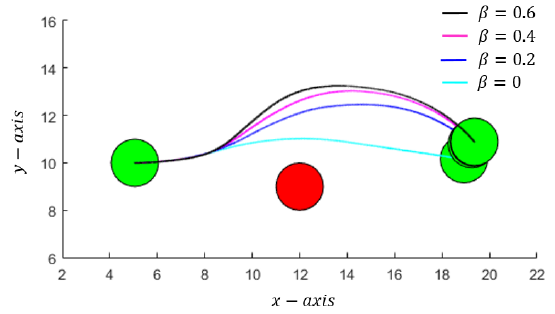
at (5,10), for selected β , while avoiding collision with a static passive agent at (12,9).